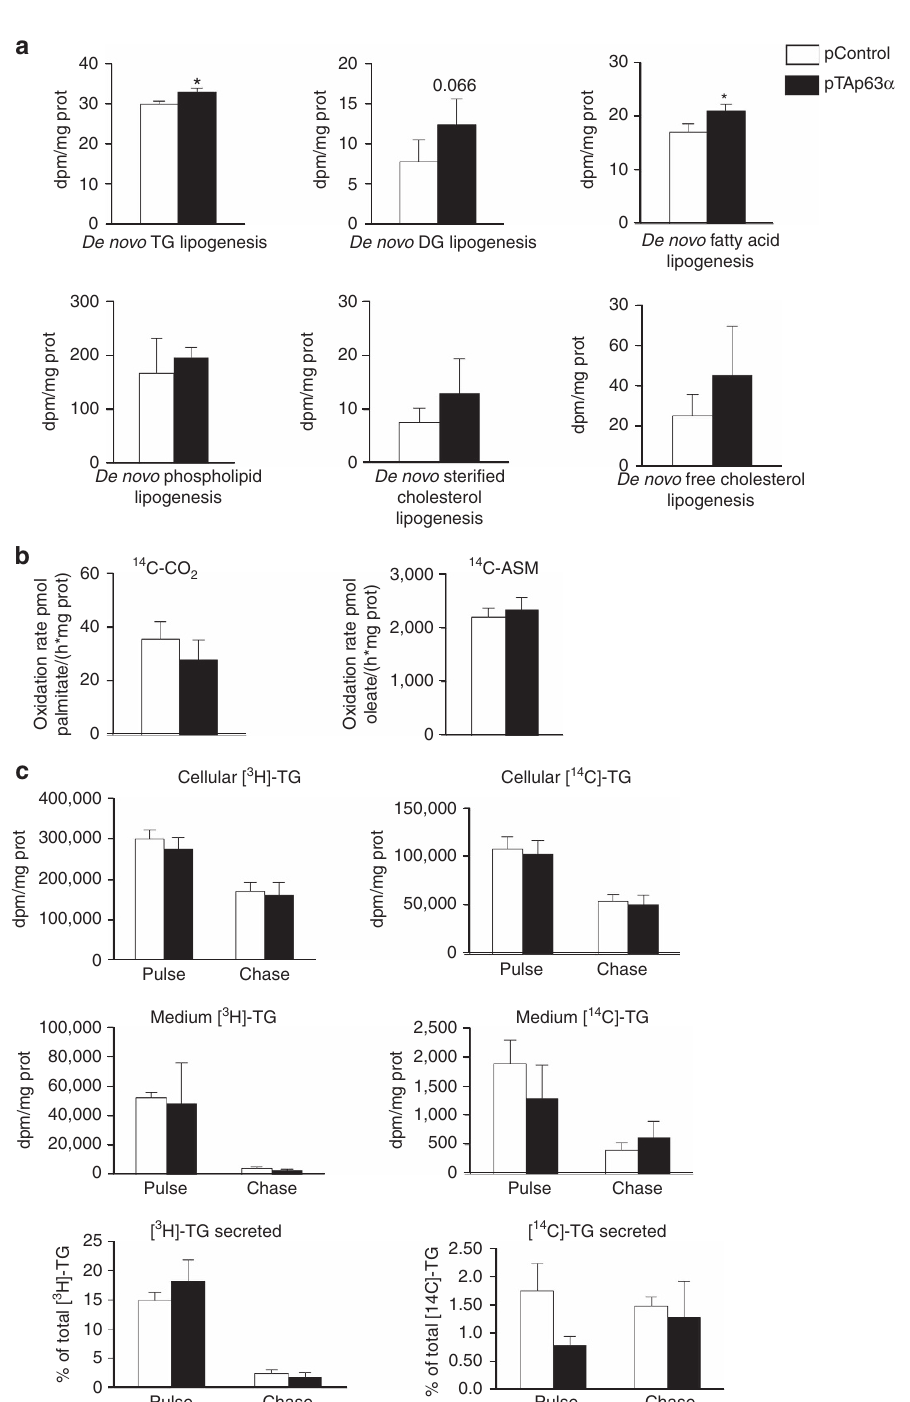
Determination of body composition . Whole body composition was measured using NMR imaging (Whole Body Composition Analyzer; EchoMRI, Houston, TX). Hematoxylin/eosin staining . Liver samples were fixed in 10% buffered formalin for 24h, and then dehydrated and embedded in paraffin by a standard procedure. Sections of 3 m m were cut with a microtome and stained using a standard Hematoxylin/Eosin Alcoholic procedure according to the manufacturer’s